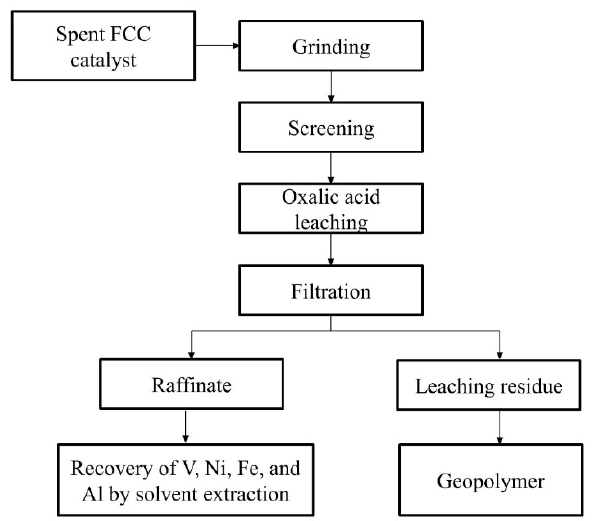
Figure 9. Process diagram of the comprehensive utilization of SFCC